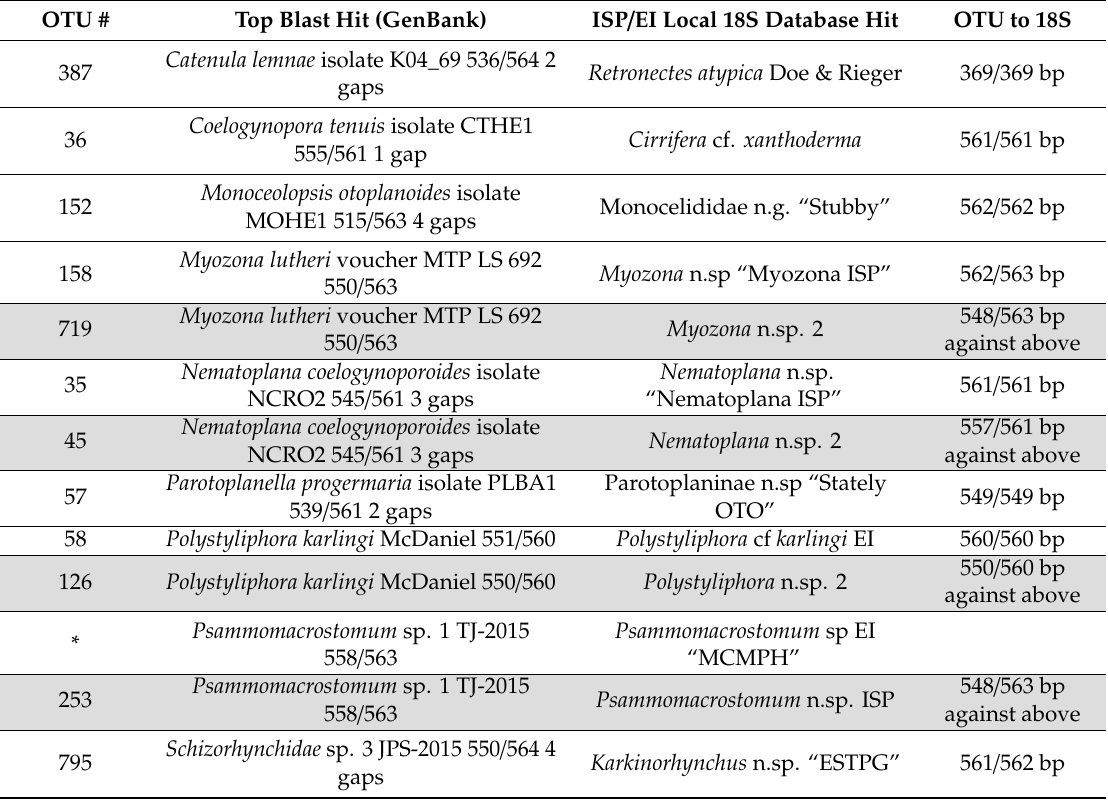
Table 8. Selected turbellarian zero-radius OTUs, from ISP or BI, that matched our in-house database of local 18S sequences, showing top blast hit, match to morphospecies for which we have 18S sequences, and four cases (shaded) of congeneric pairs occurring on these beaches. OTUs clustered with -unoise3, as implemented in Usearch 64 v.10. GenBank Blast assignment as of 4.17.20. * Specimen collected from Bogue Inlet, photo-vouchered, and